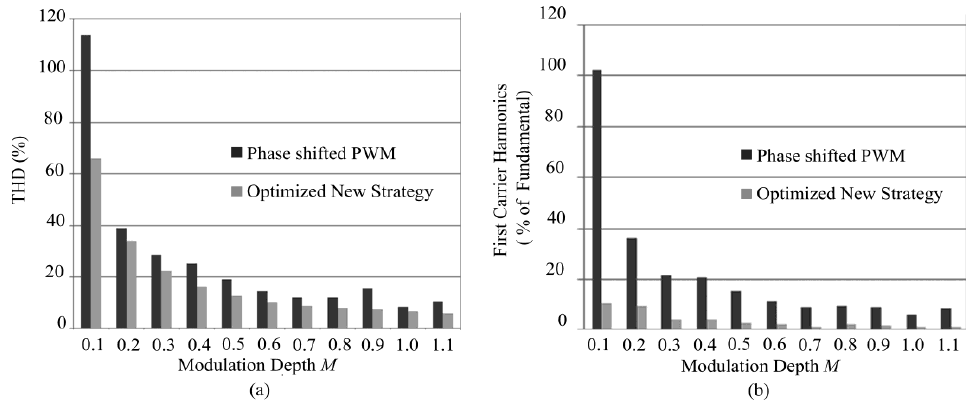
Figure 9. Detailed comparison of the THD and first carrier harmonics about the line voltage PS-PWM and the optimized new strategy: ( a ) Comparison of THD; ( b ) Comparison of first carrier harmonics.